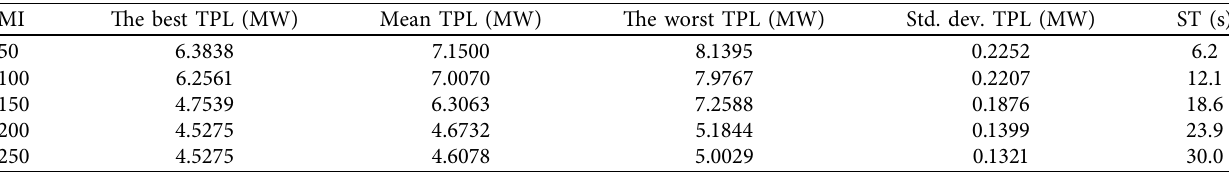
� 10 and WF � 1.0. pop